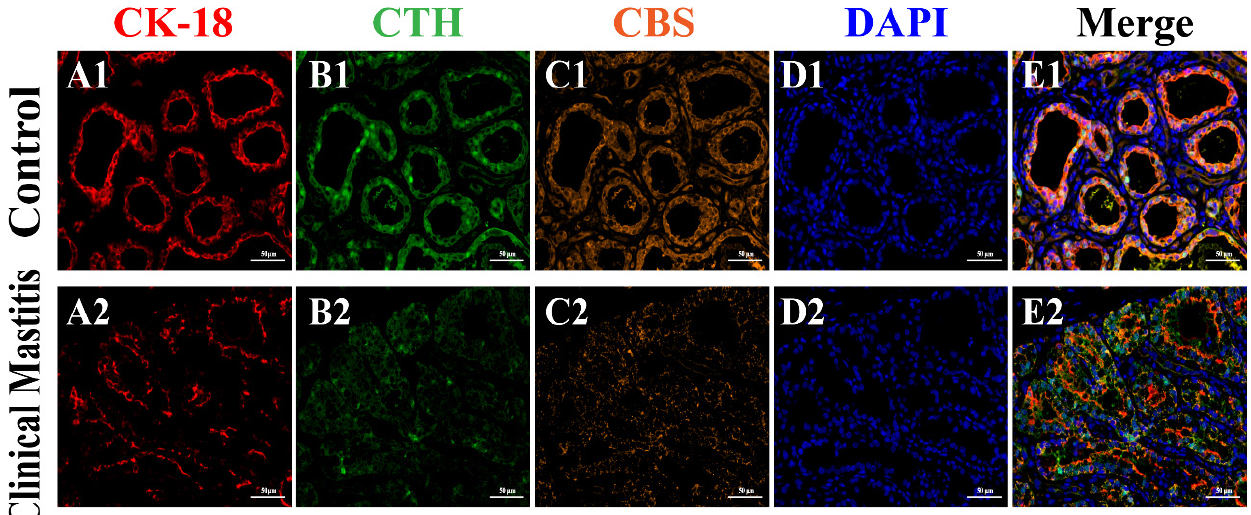
Figure 4. Co-location analysis of CBS, CTH, and CK-18 proteins in the mammary glands (400×). ( A – C ) Cellular localization of CK-18 (red), CTH (green), and CBS (orange) proteins in the mammary glands of the C ( A1 , B1 , C1 ) and CM ( A2 , B2 , C2 ) groups, respectively (400×). ( D ) Nuclei stained with DAPI (blue) in the mammary glands of the C ( D1 ) and CM ( D2 ) groups (400×). ( E ) Merged colocalization of CK-18, CTH, and CBS proteins in the mammary glands of the C ( E1 ) and CM ( E2 ) groups (400×). C, represents control. CM, represents clinical mastitis.